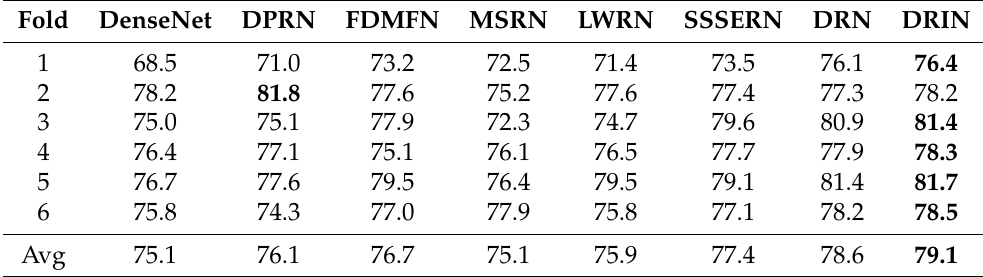
Figure 18. SV dataset. ( a ) False-color image. ( b ) Ground truth. ( c – h ) Visualization of six training–test splits. Black patches (13 × 13) contain training pixels, and the other labeled pixels are used for test. Table 15. Overall accuracies obtained by different deep models for six non-overlapping training–test splits on SV dataset. The best results are highlighted in bold font.